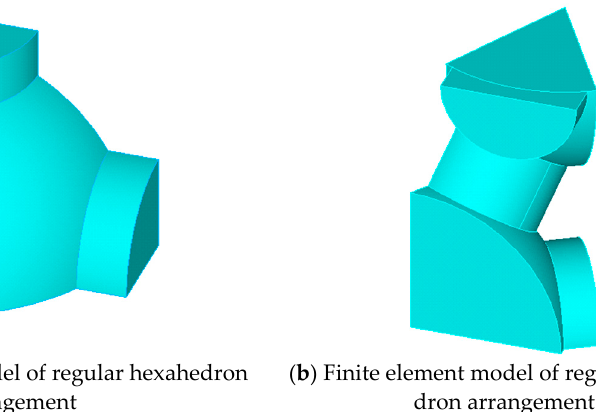
Figure 10. Finite element model of RVE.